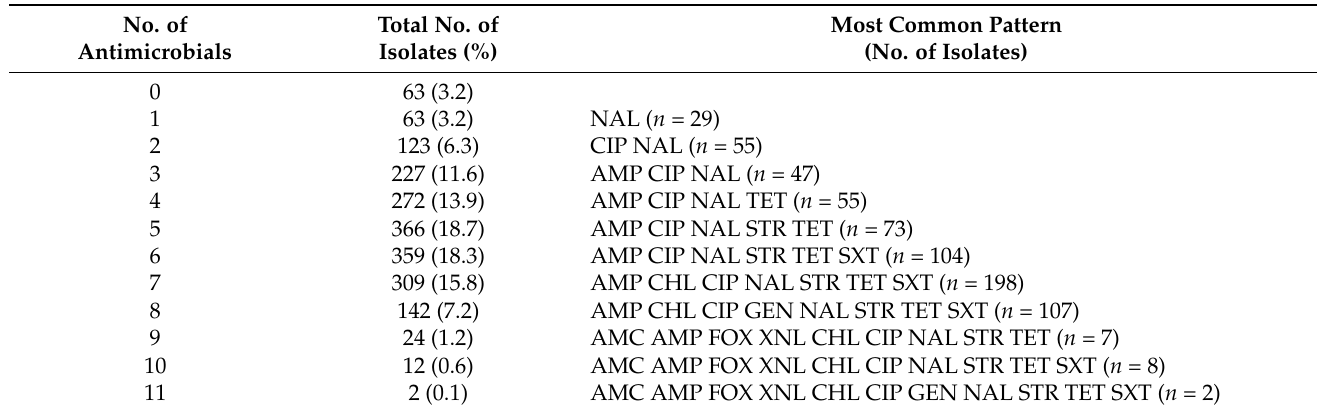
Table 5. Frequent resistance patterns in E. coli isolated from healthy chickens between 2010 and 2020 in Korea ( n =